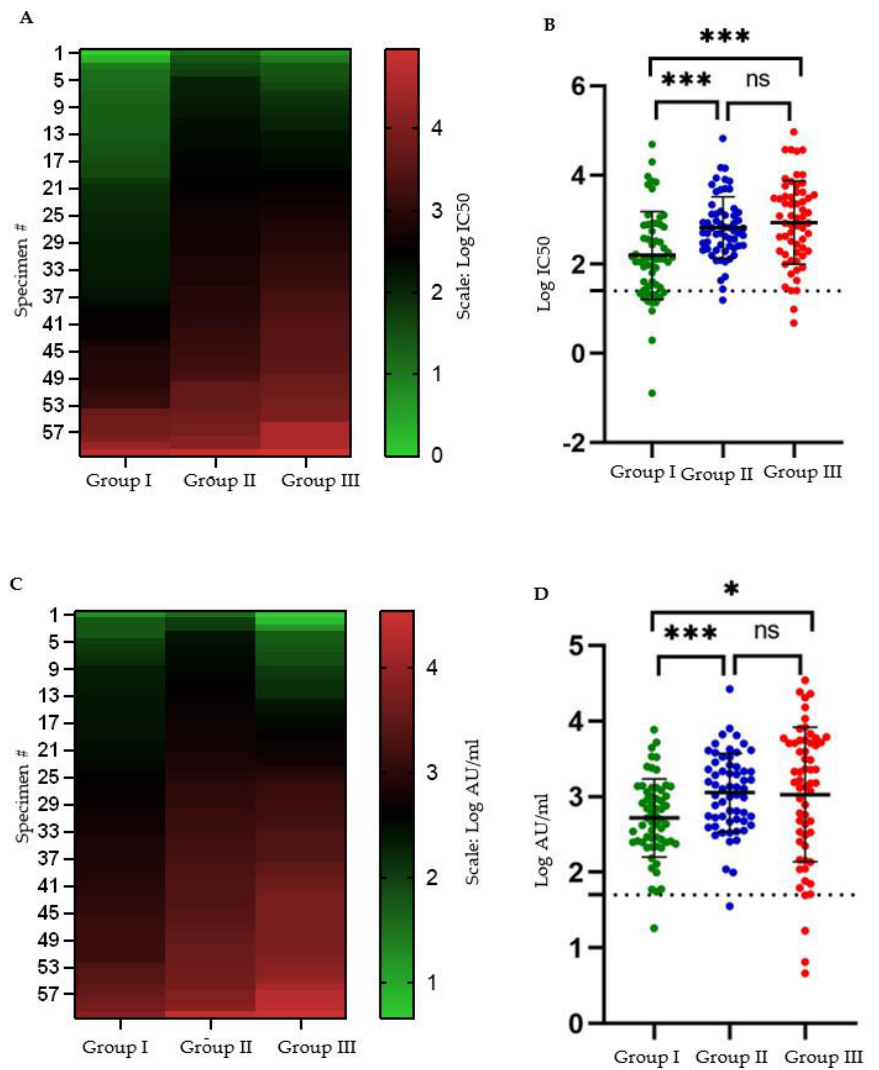
Figure 3. Log10 IC50 ( A , B ) and log10 AU/mL ( C , D ) values obtained following pseudotyped lentivirus antibody neutralization assay, and SARS-CoV-2 IgG II Quant immunoassay, respectively, on specimens from each of the three groups of study participants. The horizontal dotted lines in B and D indicate the assay cutoff at IC50 = log10(25) for the neutralization assay, and Log10(50) AU/mL for the immunoassay, respectively. # = number, ns: not significant, *: p < 0.05, ***: p < 0.005. (Note: values below zero have been rounded to zero in panels A and C).